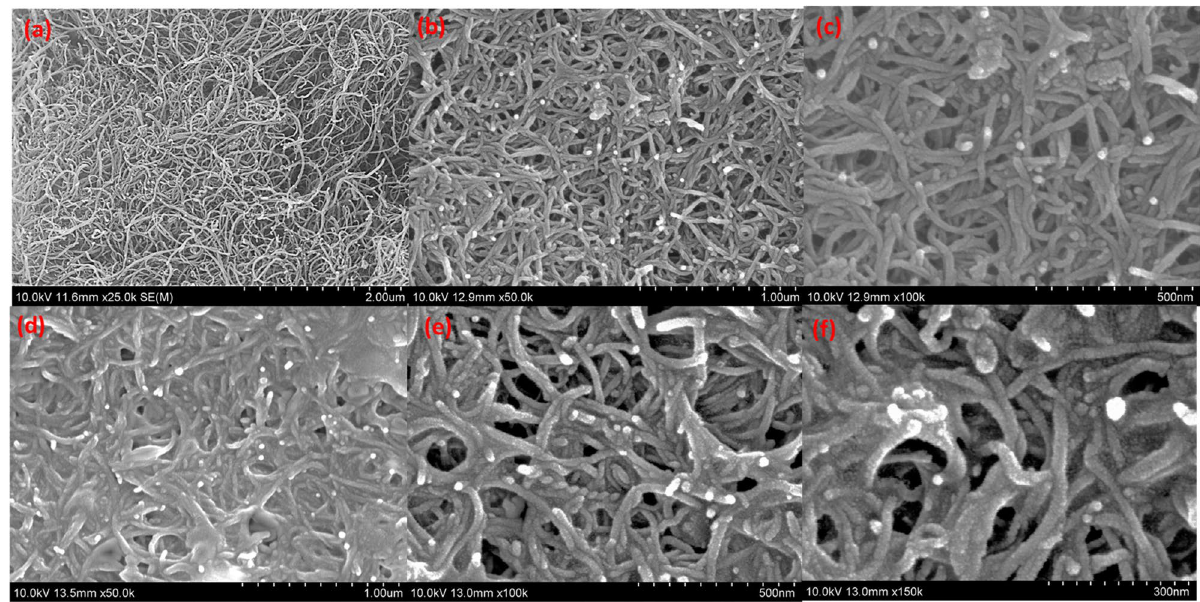
Figure 3. FE-SEM images for ( a ) TWCNT, ( b , c ) TWCNT/PVA, and ( d – f ) borax: